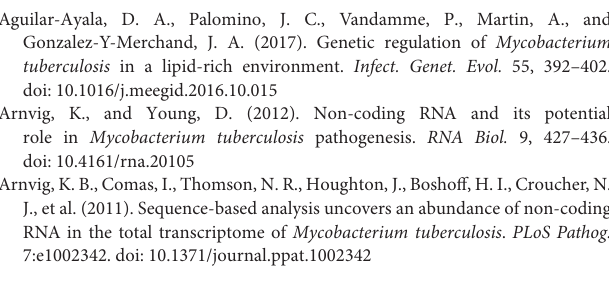
Table S1 | Oligonucleotides used in the study. Table S2 | NGS data. Table S3 | Confirmation of NGS data by qPCR. Two different sets of genes were checked for changes in transcripts level in days 2, 4, and 7 vs. dormancy (1), and